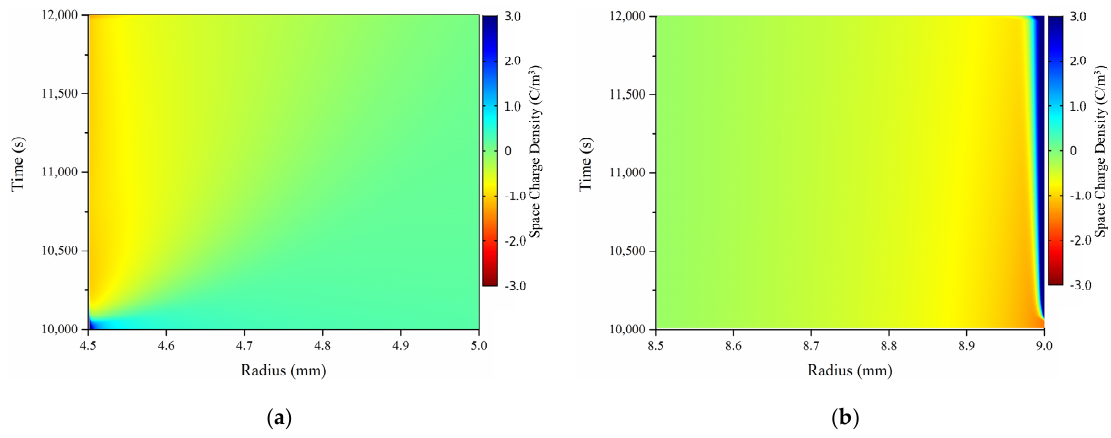
Figure 17. Space charge distribution at 350 A and potential zero duration 1800 s: ( a ) Conductor side density (C / m 3 ); ( b ) sheath side density (C / m 3 ).